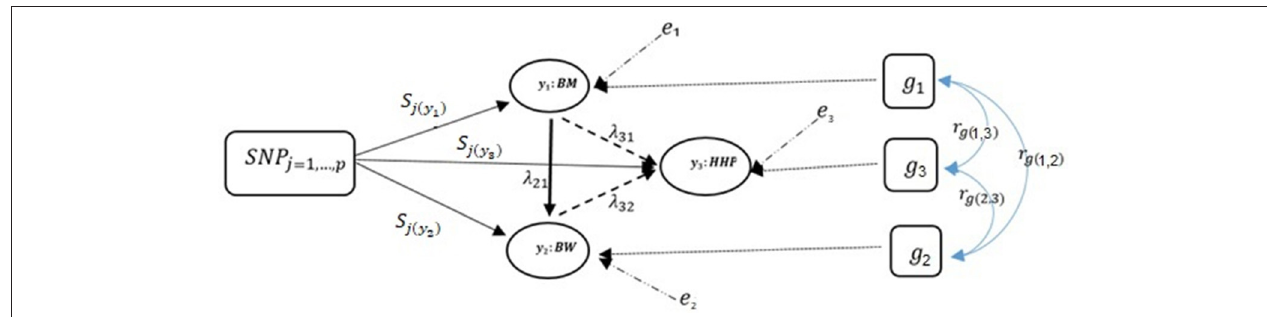
FIGURE 2 | A diagram for causal path analysis of SNP effects in a fully recursive structural equation model for three traits, p exogenous independent SNP variables, and three correlated polygenic effects. Arrows indicate the direction of causal effects and dashed lines represent associations among the three phenotypes. Genetic correlation between traits ( r g ), polygenic effects ( g t ), environmental effect on trait t ( e t ), effects of j th SNP on t th trait ( S j ( y phenotype l ( λ ). Dashed lines indicate negative coefficients and the continuous arrows indicate positive t , t ′